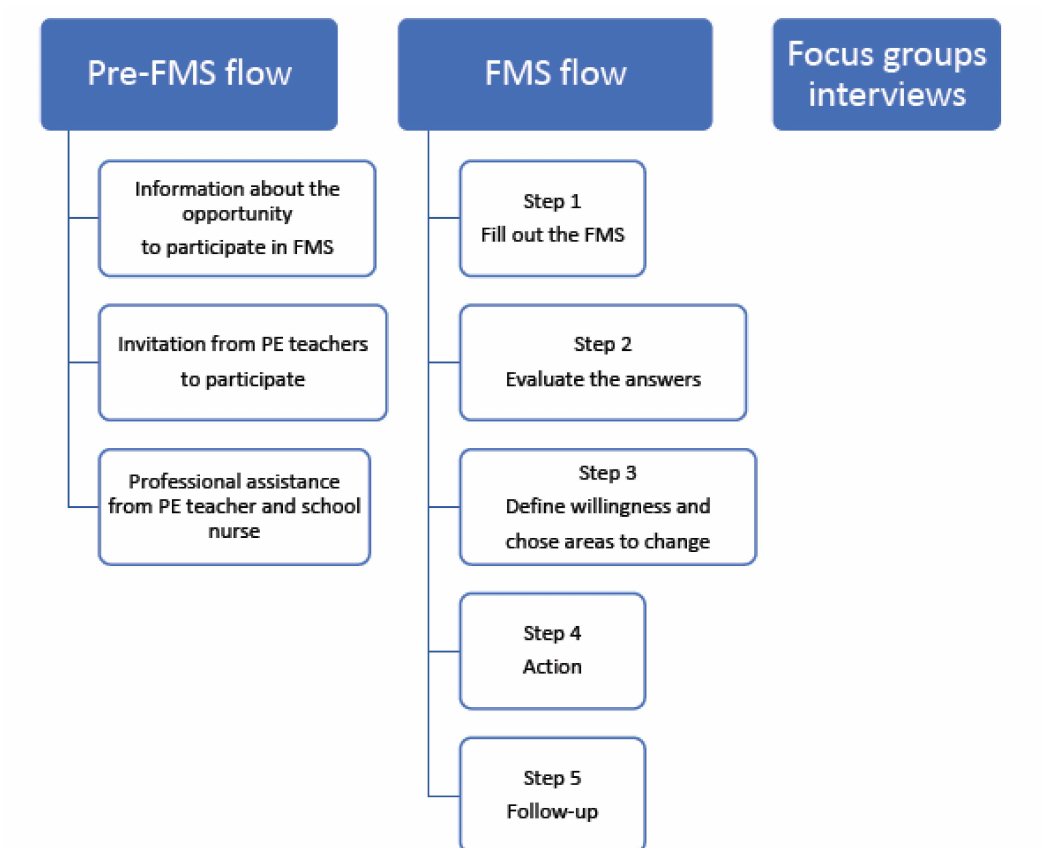
Figure 1. Flow chart showing the flow of FMS Swedish Physical Power Mental Harmony and Social Capacity (FMS) Student